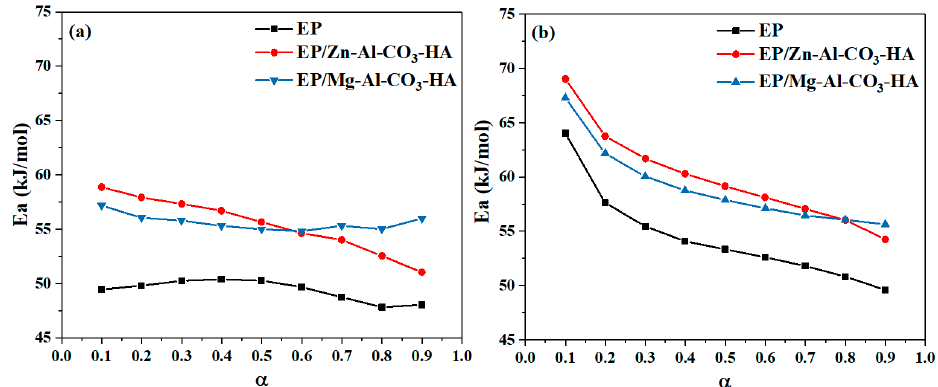
Figure 8. Estimation of the activation energy for the EP, EP / Zn-Al-CO 3 -HA, and EP / Mg-Al-CO 3 -HA nanocomposites: ( a ) differential Friedman and ( b ) integral Kissinger–Akahira–Sunose ( KAS ) models. Table 4. The kinetic parameters of neat epoxy and its nanocomposites based on the Friedman and KAS